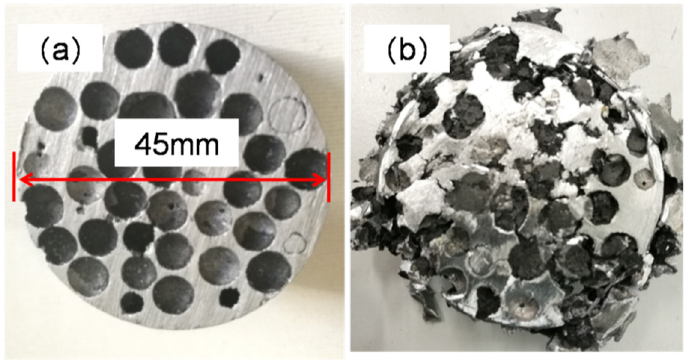
Figure 10. Top views of the ASF-II: ( a ) Before compressive test; ( b ) After compressive test (60% strain).